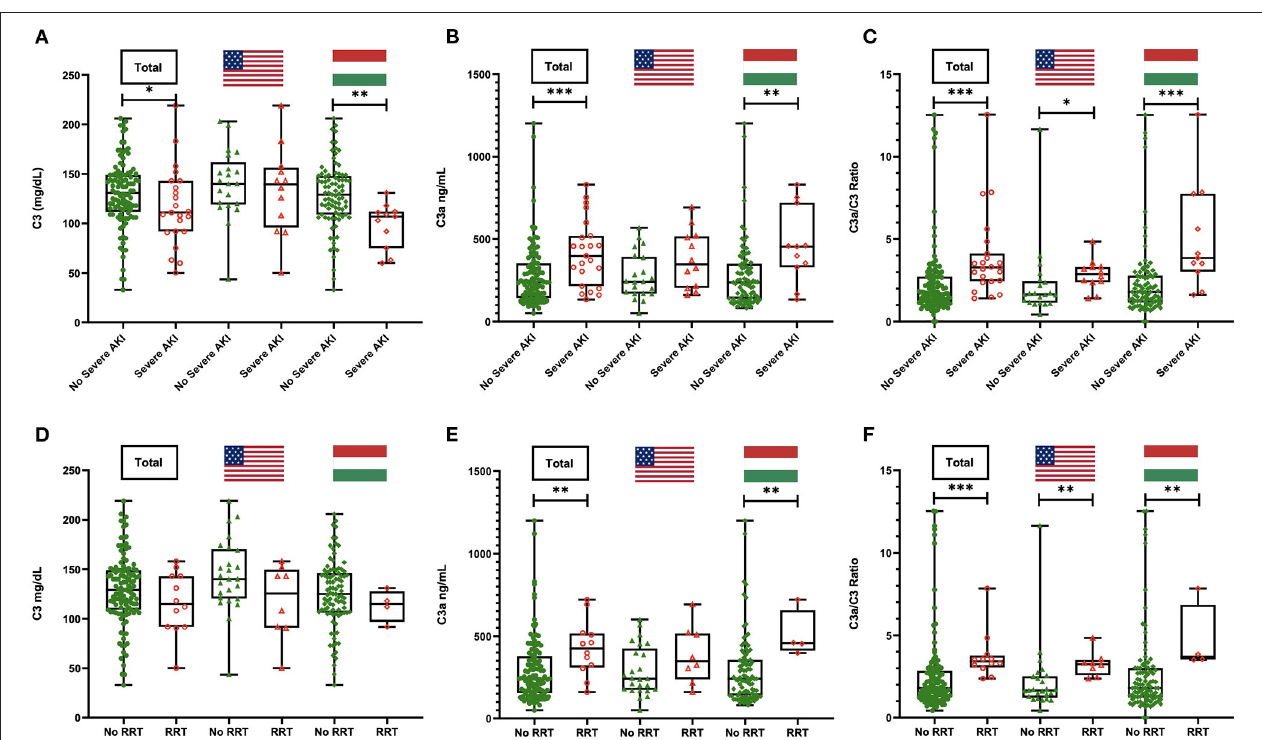
FIGURE 1 | C3, C3a, and C3a/C3 ratio levels in patients with or without severe acute kidney injury (AKI) (A–C) and with or without need for renal replacement therapy (RRT) (D–F) in the total cohort and stratified by country. * P < 0.05; ** P < 0.01; *** P < 0.001.